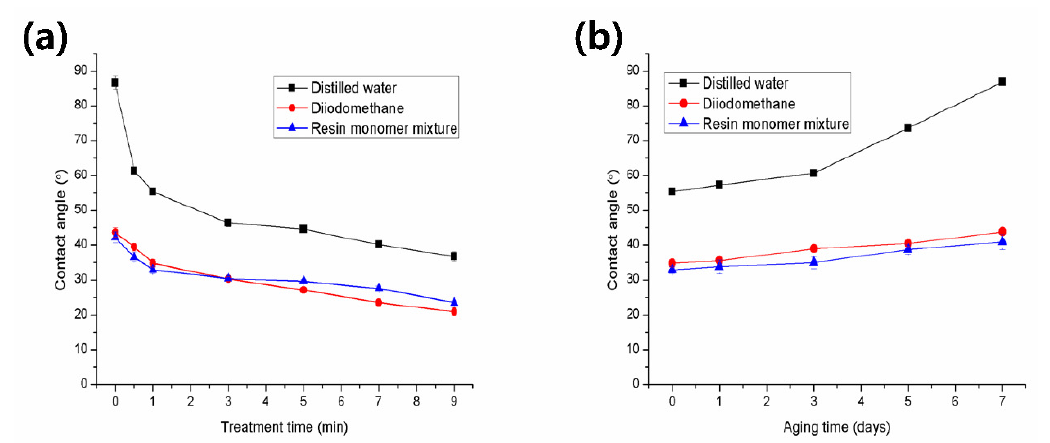
Figure 4. The contact angle following use of distilled water (black square), diiodomethane (red circle), and resin monomer mixture (blue triangle) on the surface of epoxy resin as; ( a ) increasing treatment time of non-thermal atmospheric pressure nitrogen plasma; ( b ) time following the treatment to non-thermal atmospheric pressure nitrogen plasma. There was a statistically significant difference ( p < 0.05) between all test groups.